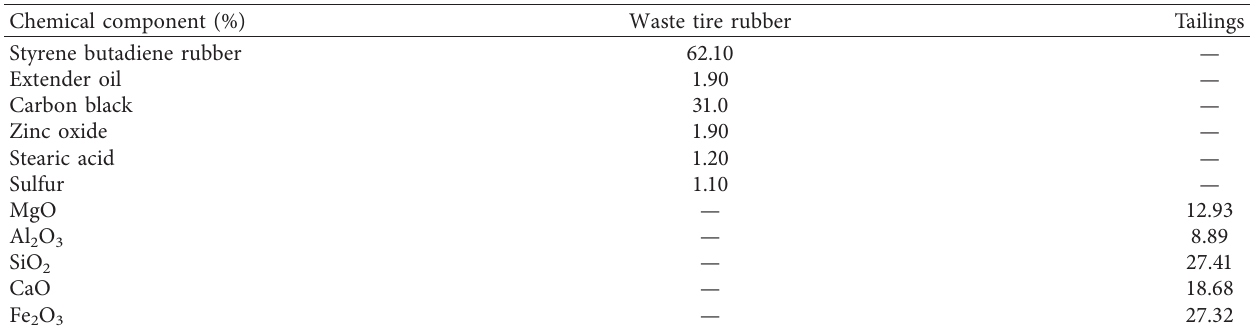
Figure 1: Curves of (a) particle size distributions and (b) XRD of tailings. Table 1: Main chemical and physical properties of the rubber fiber and tailings.